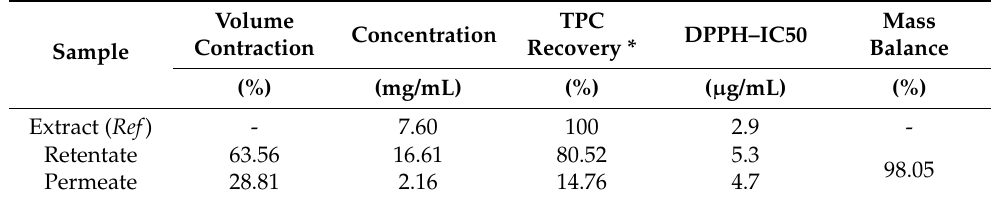
Table 8. UF protocol. Volume contraction, TPC variations, antioxidant activity (DPPH), and mass balance of the